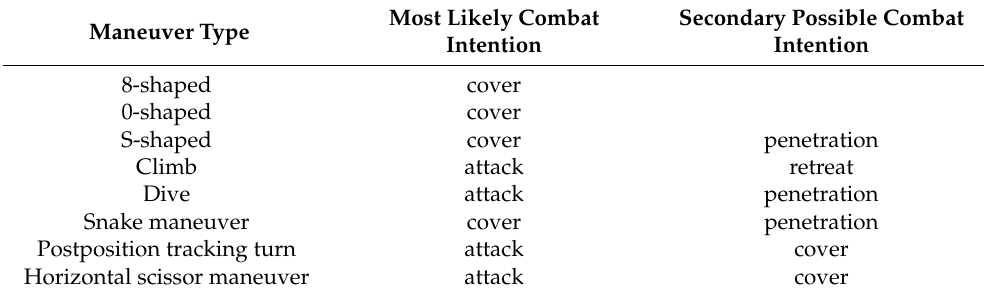
Table 3. The relationship between maneuver type and the combat intention of the target fighter.